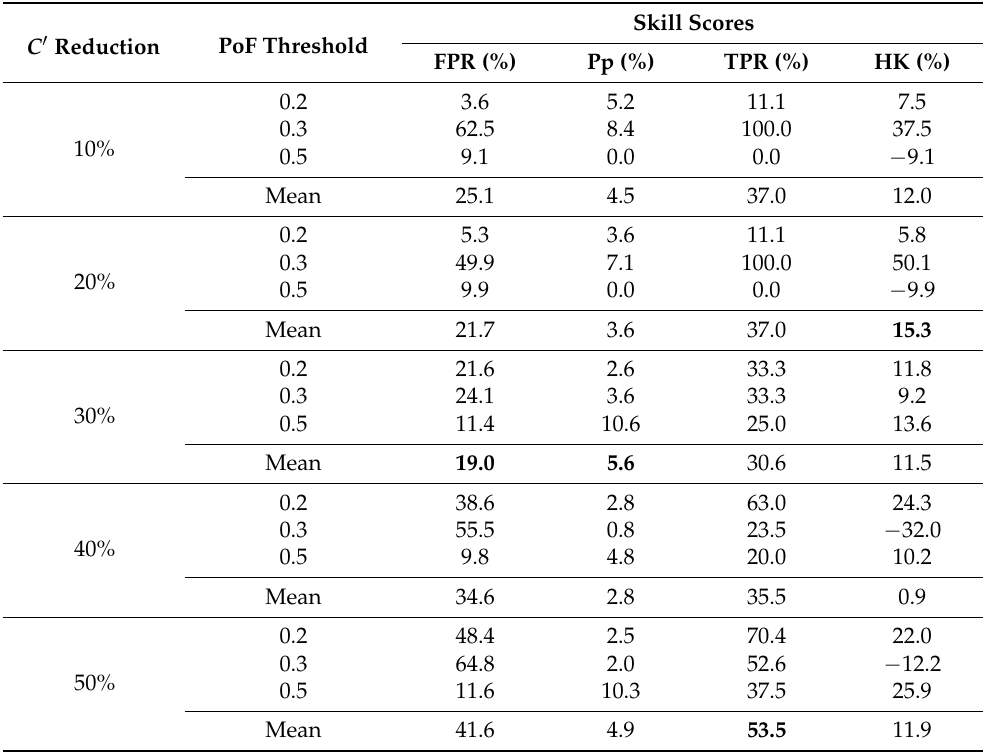
Table 2. Values of the calculated skill scores for the five cases of c (cid:48) reduction and the three PoF threshold values. For each case of c (cid:48) reduction, the average value for each skill score is also reported. The best average values for each skill score are in